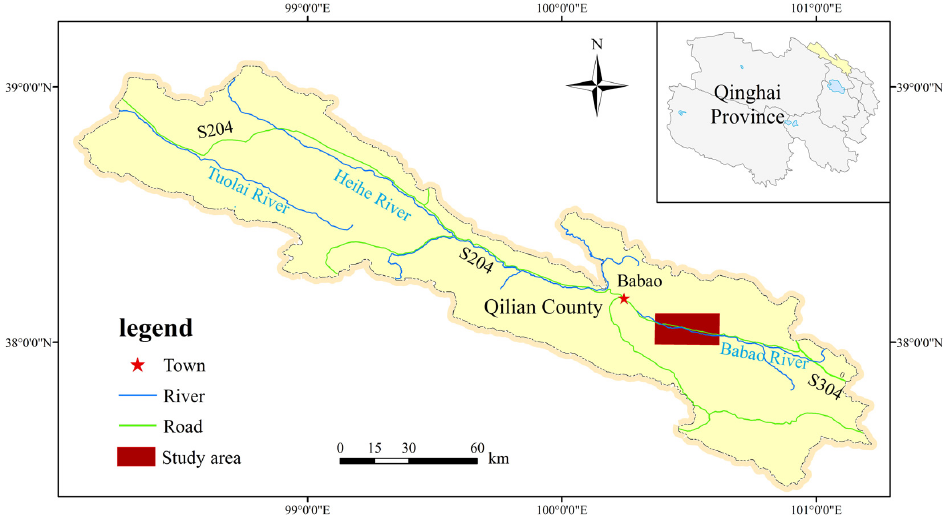
Figure 1. Study area located in Qilian County of Qinghai Province, China.